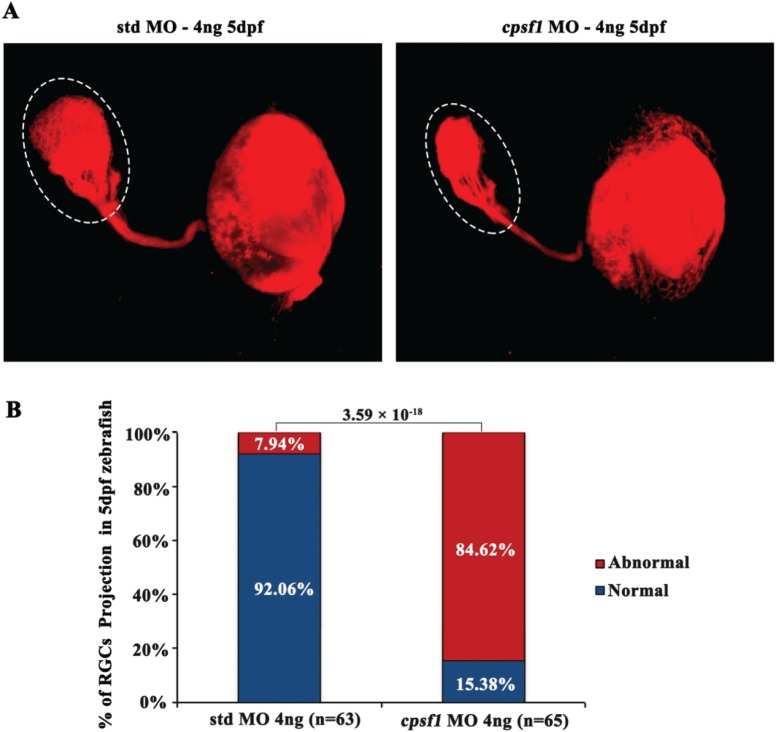
RGC axon projection to the tectum was abnormal in cpsf1 morphants. (A) RGC axon projection in zebrafish at 5 dpf. Left: RGC axon projection in std MO-injected zebrafish, right: RGC axon projection in cpsf1 morphants. Data showed that cpsf1 morphants showed less innervation to the tectum than std MO-injected zebrafish. (B) Histogram of the percentage of larvae with the phenotype of reduced innervation of the tectum. The area of the tectum with DiI tracing was 18570.60 ± 3969.32 μm2 (n = 63) in std MO-injected zebrafish, and 8895.07 ± 3756.63 μm2 (n = 65) in cpsf1 MO-injected zebrafish. Approximately 84.62% of cpsf1 morphants displayed reduced area of the tectum, but only 7.94% of std MO-injected zebrafish had this phenotype (P = 3.59 × 10−18, Chi-square test). The number of zebrafish injected in each group is indicated under each column.